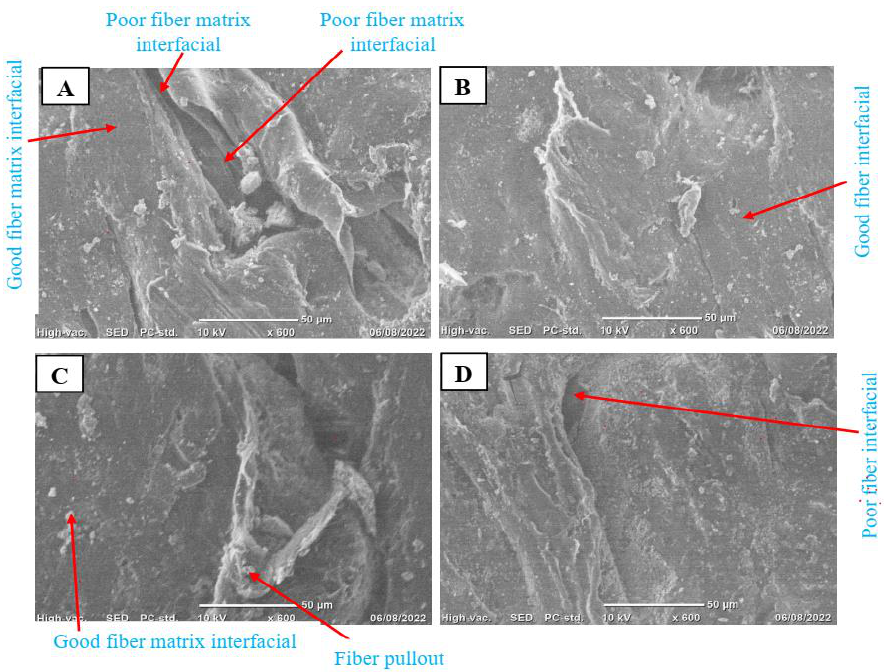
Figure 7. SEM image of ( A ) 75 wt% treated, ( B ) 65 wt% treated, ( C ) 75 wt% untreated, and ( D ) 65 wt% untreated CH composites.